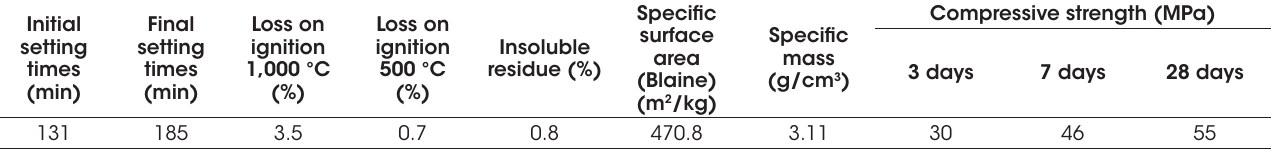
Physical characterization of high initial strength Portland cement Initial setting times